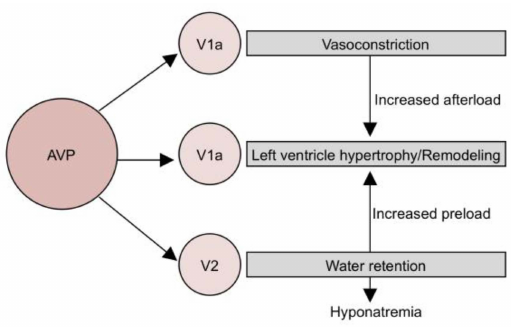
Figure 1. Effects of AVP in heart failure—the vicious